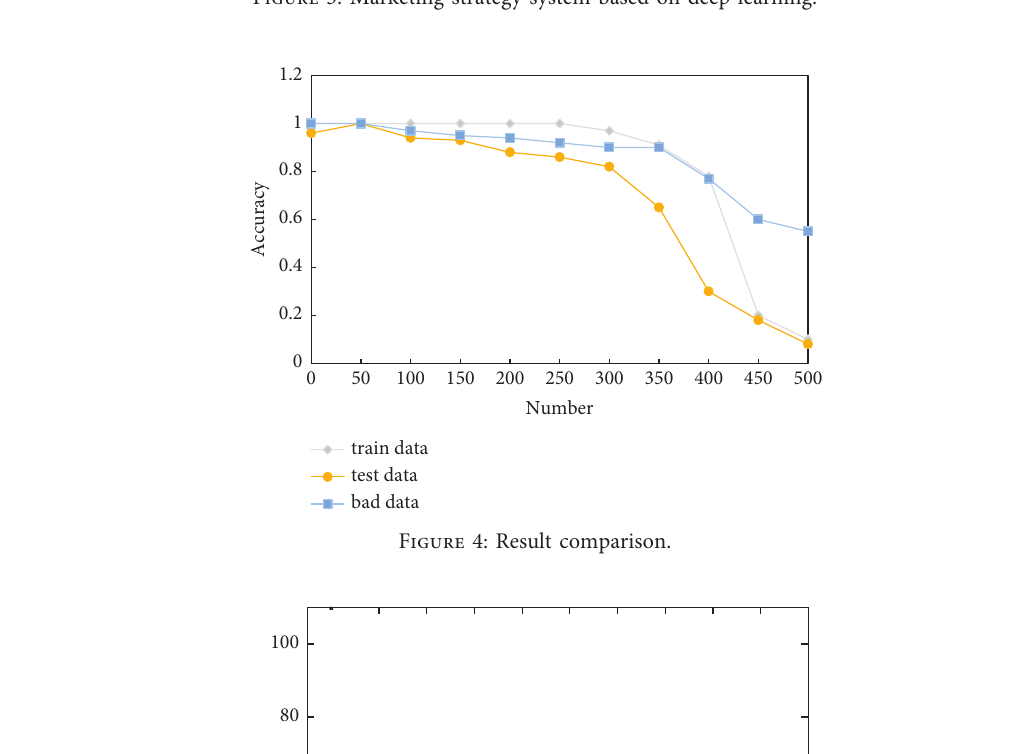
Figure 3: Marketing strategy system based on deep learning.